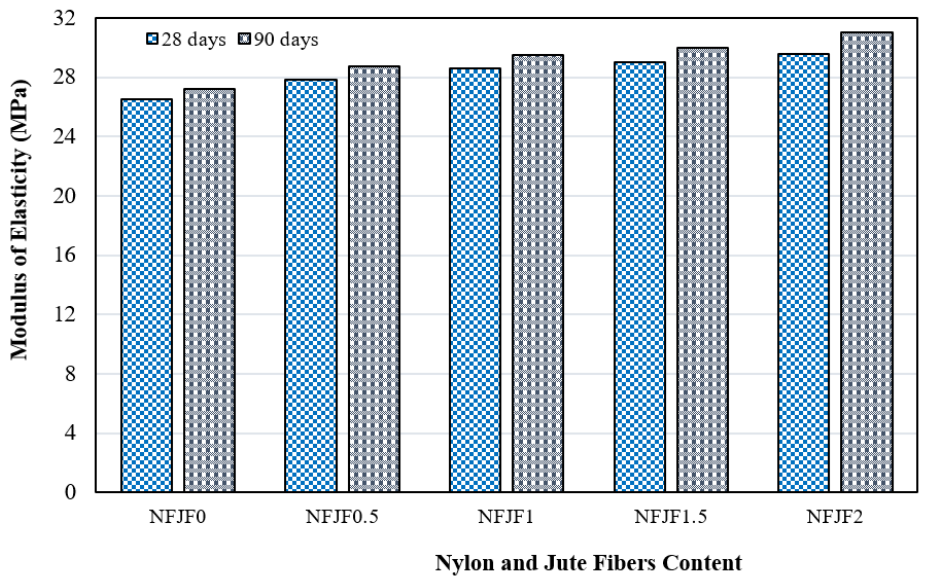
Figure 10. Modulus of elasticity of concrete.